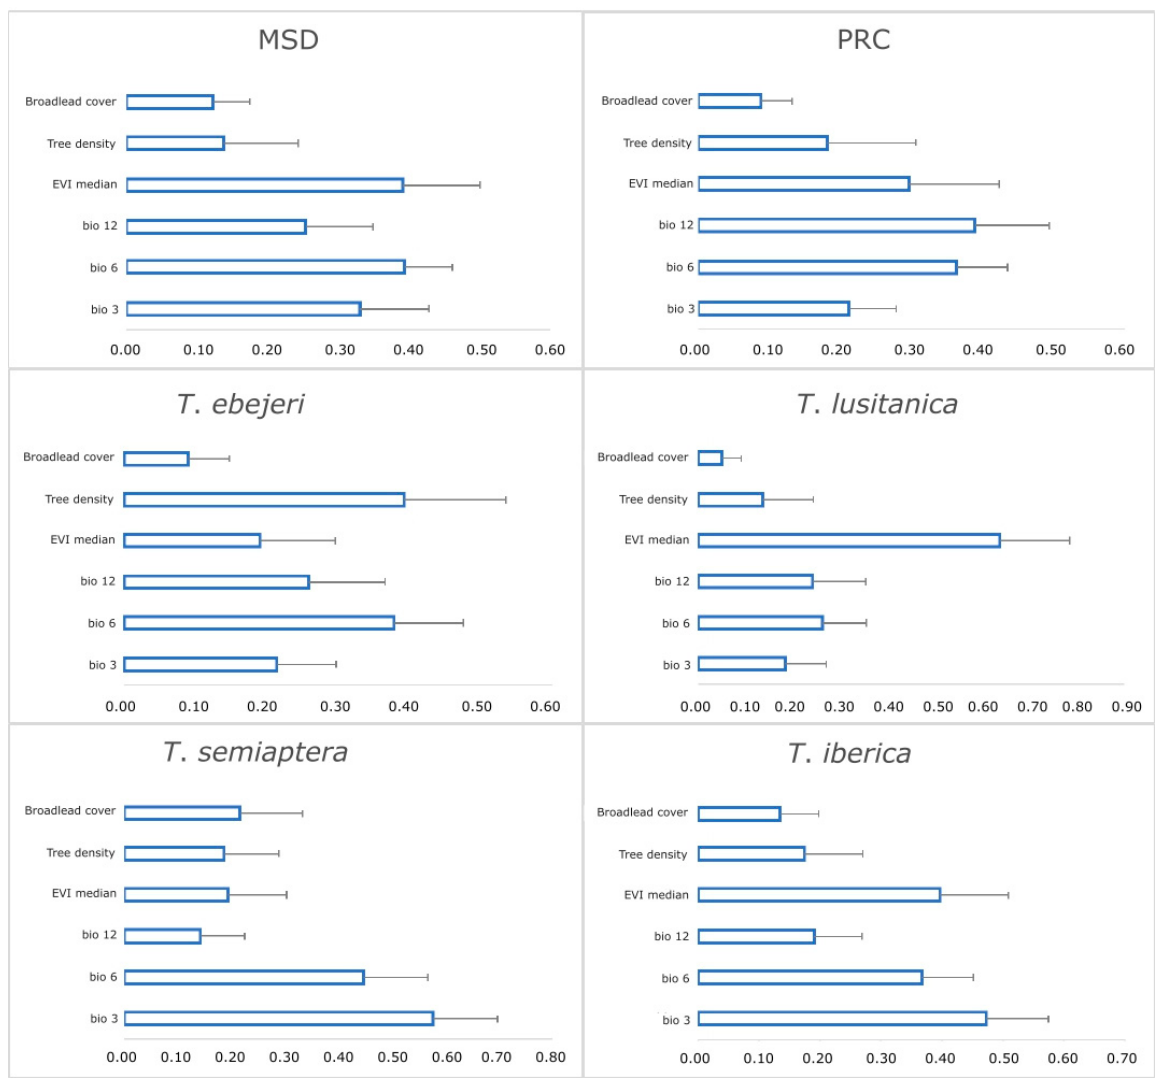
Figure 2. The relative importance of the abiotic and biotic variables used to predict the distributions of the individual species and groups thereof (i.e., MSD—merged species dataset with all species pooled together and PRC—most-phylogenetically related species). Bars indicate the mean value of relative importance obtained from the ten different modelling algorithms, while the whisker indicates the ½ standard deviation. EVI—Enhanced Vegetation Index; bio 3—isothermality; bio 6—Minimum Temperature of Coldest Month; bio 12—Annual Precipitation.